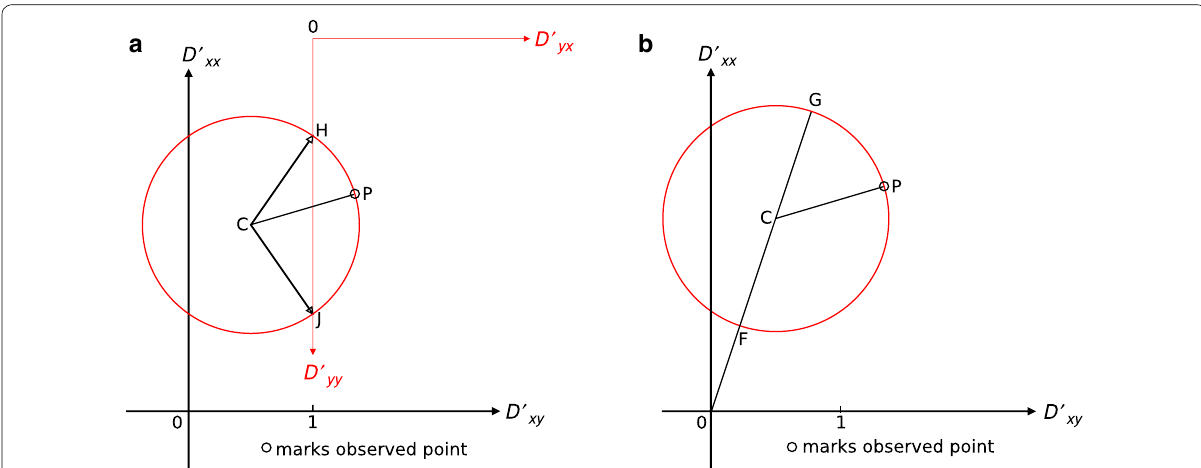
Fig. 1 a Example eigananalysis Mohr diagram adapted from Lilley (2015). Points H and J mark the eigenanalysis positions, and the eigenvalues are the D ′ xx values of points H and J. b Example Mohr diagram for singular value decomposition adapted from Lilley (2015). OG and OF represent the greater and lesser singular